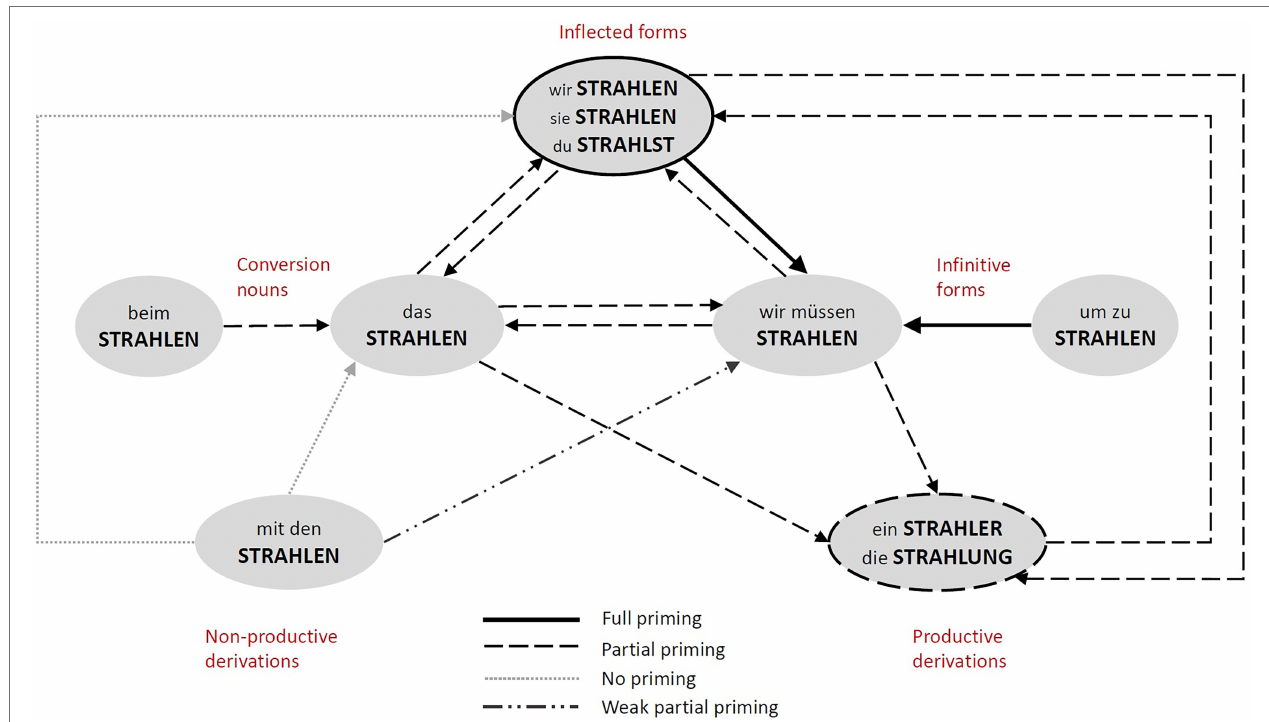
FIGURE 5 | The figure represents a simplified summary of the priming relationships, focusing on the non-finite forms (conversion nouns and infinitives) in the centre. It combines the priming results of the current study and those of Bordag and Opitz (2021). The types of lines represent the different degree of priming between the forms. Arrows correspond to the priming direction. For the sake of clarity, some of the forms are collapsed into one circle (i.e., inflected forms and productive derivation) and the type of priming between them is represented in the line type of the circle (i.e., full priming between inflected forms, partial priming between productively derived